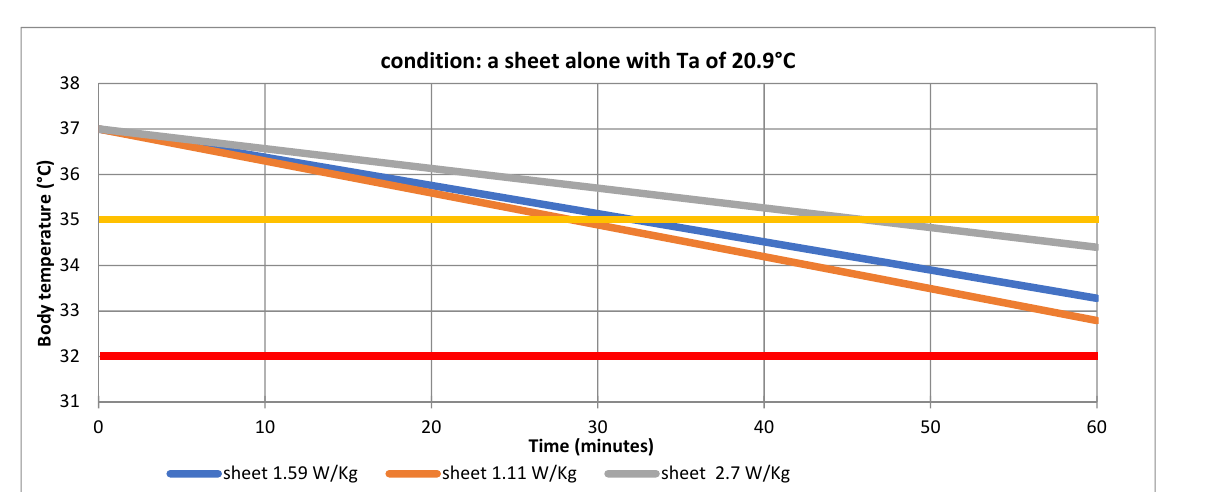
Comparisons of the heat power values given in Tables 1 (R + C) and 2 (R + C + K)